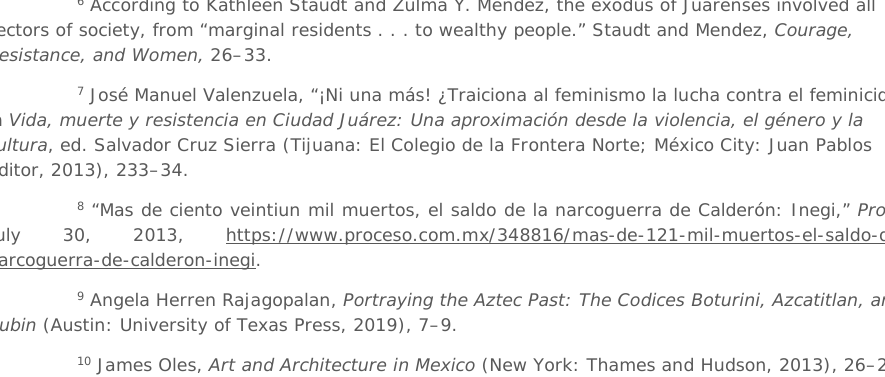
The coexistence of institutionalized violence and criminal violence created a lawless environment in some parts of Mexico, the resulting chaos was then disseminated through the national and international media and persisted throughout the presidency of Enrique Peña Nieto (2012–2018). It is to this context, in which more than 121,683 people have died in Mexico in drug-related violence since 2006, that Gabriel Garcilazo responds and asks us to reflect upon. 8 In his multi-part artwork Dystopic Magical Codex (2015), he questions the policies of a failed war. Dystopic Magical Codex is inspired by pre-Hispanic codices. Sixteen- century codices in pre-Hispanic Mexico were handmade and hand-painted books originally pleated to create an accordion-style composition. 9 Pre-Hispanic manuscripts were made on deer hide or bark paper; during the Spanish colonial era, they were made with European paper, its folios bound together like a book. 10 In his modern-day codex, Garcilazo employed and displayed separate sheets of paper in individual frames (Fig.1). In Dystopic Magical